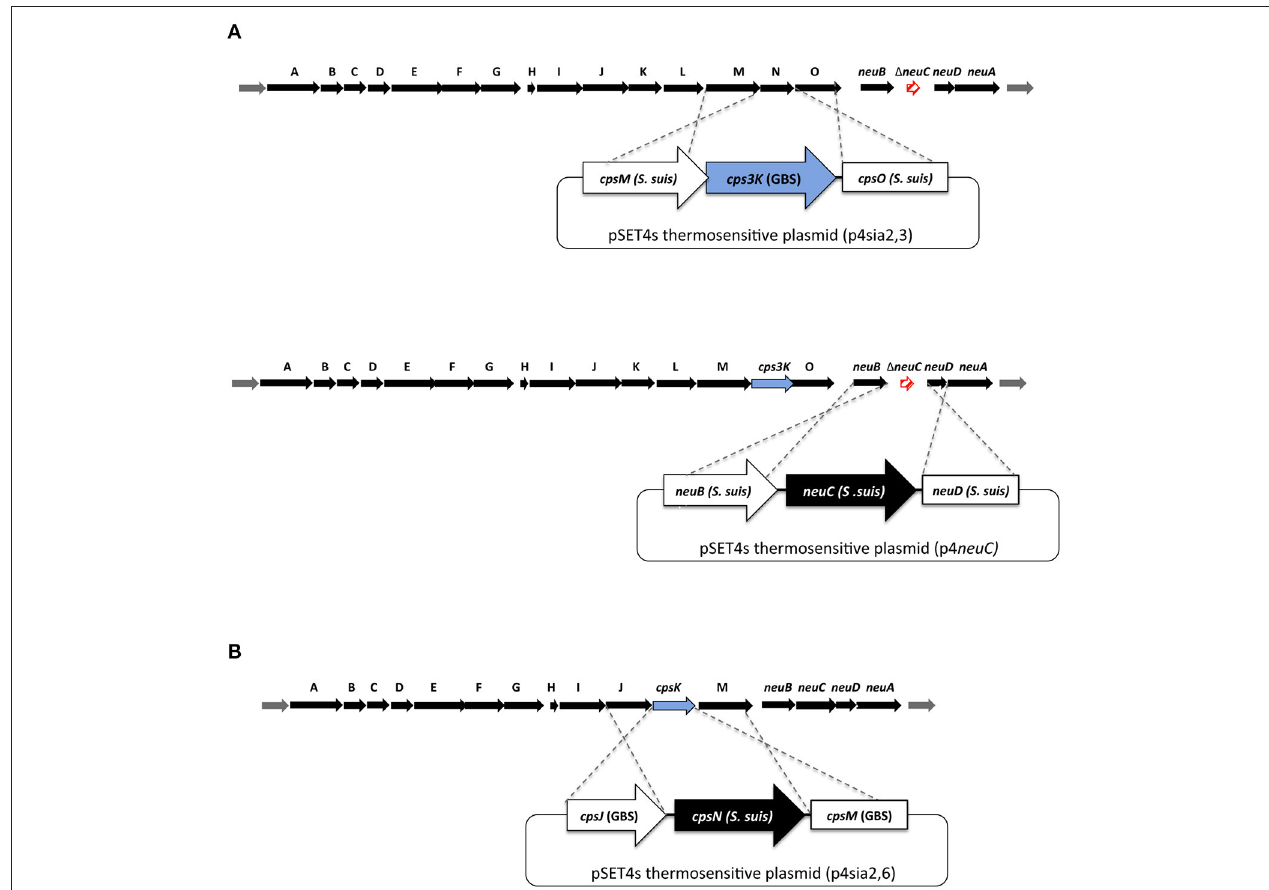
FIGURE 2 | Schematic representation of mutagenesis procedures to obtain sialyltransferase substitution mutants in (A) S. suis and (B) Group B Streptococcus (GBS). ( A ; top part) Non-lethal mutation in neuC ( 1 synth) was used first to abolish capsular polysaccharide (CPS) production. Gene substitution plasmids p4sia2,3_2 and p4sia2,3_14 were introduced into S. suis SS2 1 synth (serotype 2) and SS14 1 synth (serotype 14) mutants, respectively. ( A ; bottom part) In order to reintroduce a functional neuC gene into SS2 1 neu2C / cps3K and SS14 1 neu14C / cps3K mutants, the p4 neuC plasmid was introduced into SS2 1 neu2C / cps3K and SS14 1 neu14C / cps3K mutants to obtain indirect substitution mutants SS2sia2,3 and SS14sia2,3. (B) In order to substitute GBS type III and V sialyltransferases, direct gene replacement by double-crossover homologous recombination system was used by introducing mutation plasmids p4sia2,6_III and